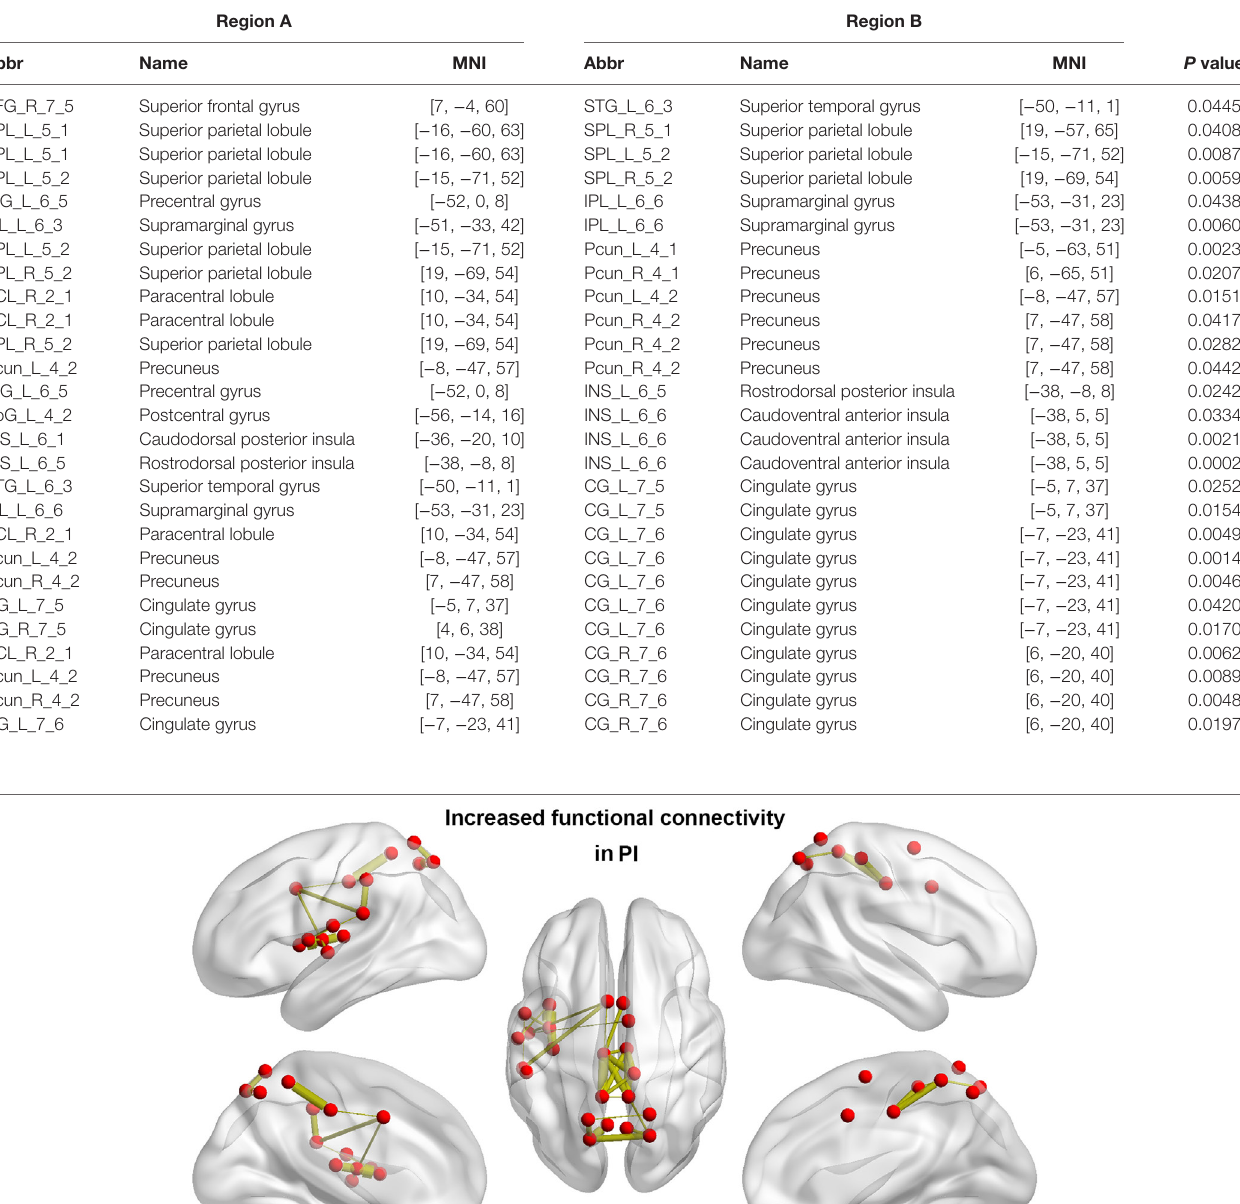
TaBle 2 | Connections showing increased functional connectivity in the PI